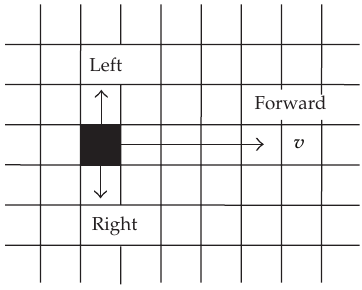
Figure 1: The pedestrian movement